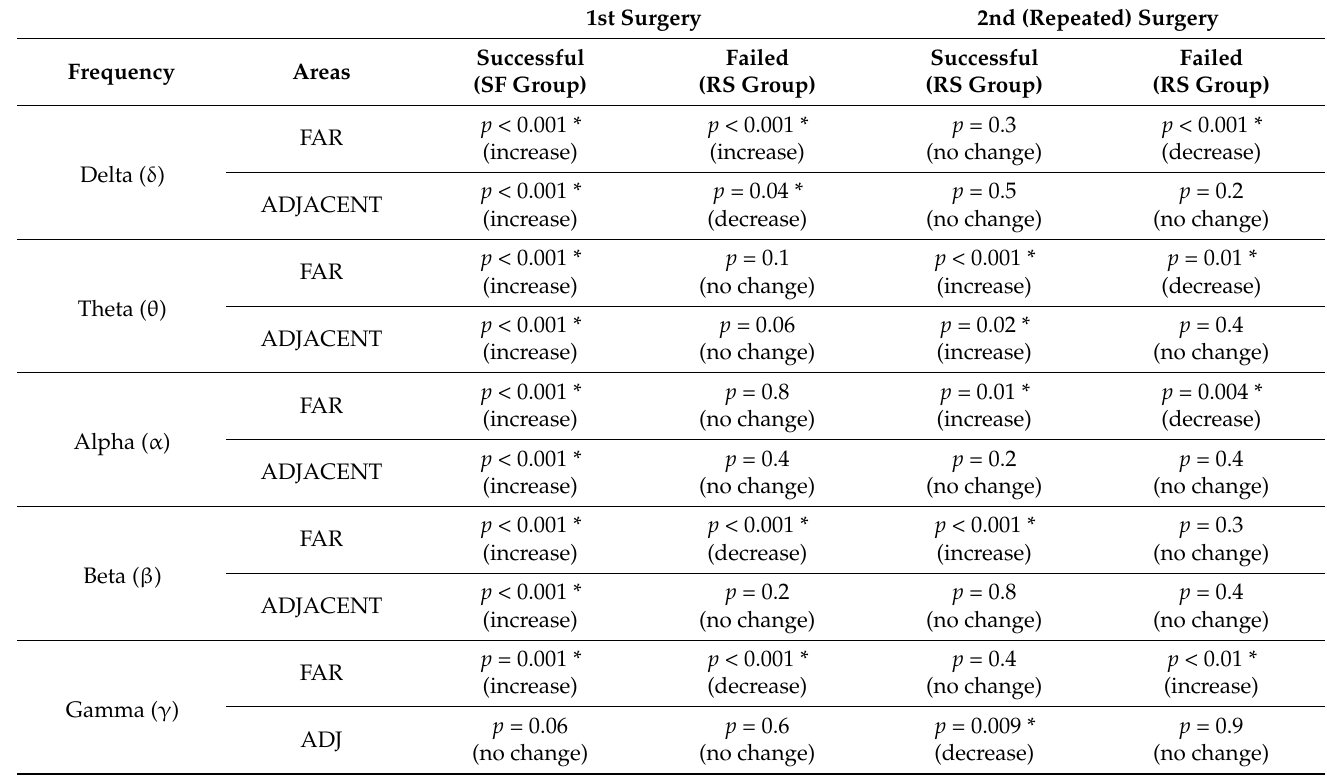
Table 2. Analysis of post-surgical changes in the global centrality of far and adjacent regions. 1st Surgery 2nd (Repeated)